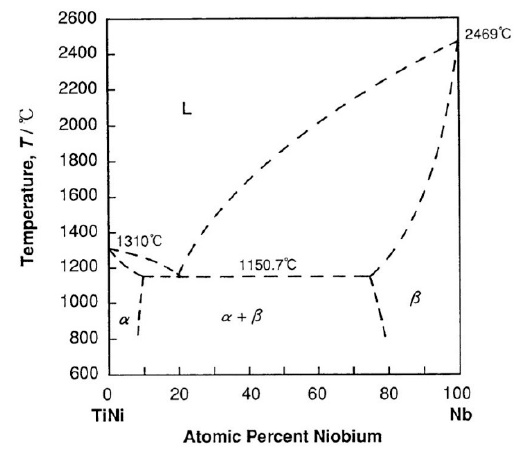
Figure 6. Quasi-binary TiNi-Nb phase diagram [10].